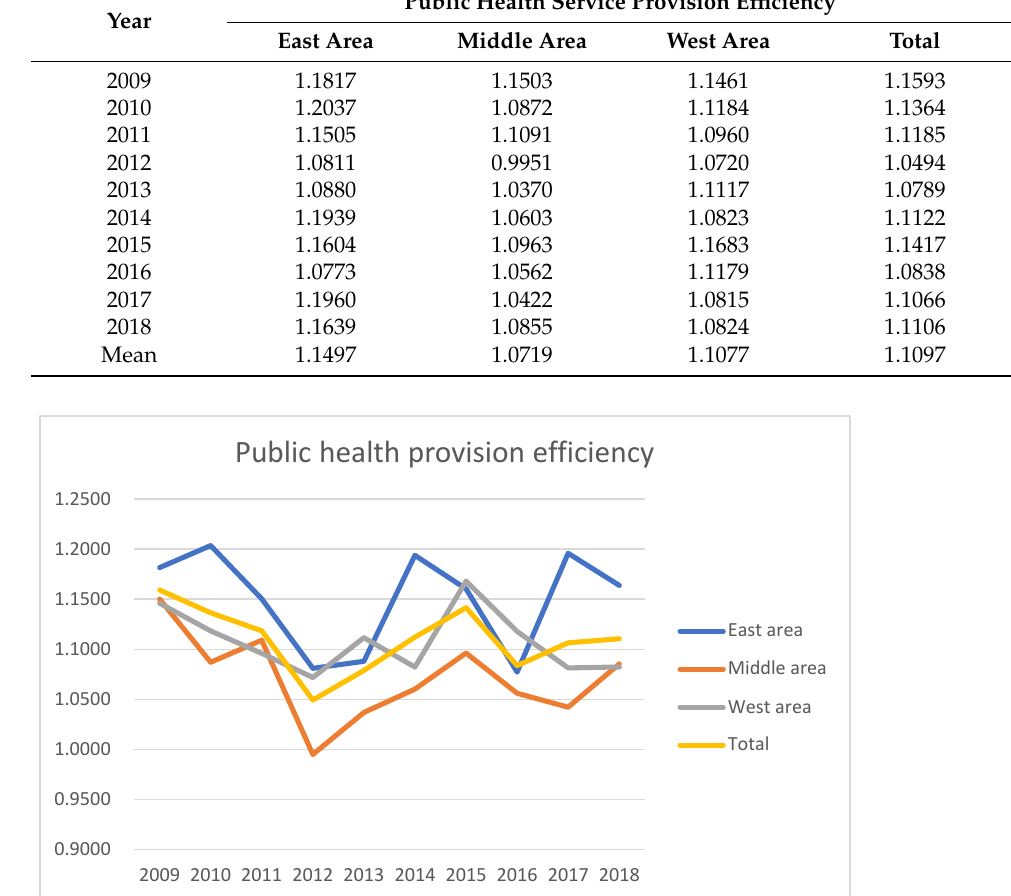
Figure 3. Mean value of the public health provision service efficiency in eastern, middle and western areas.